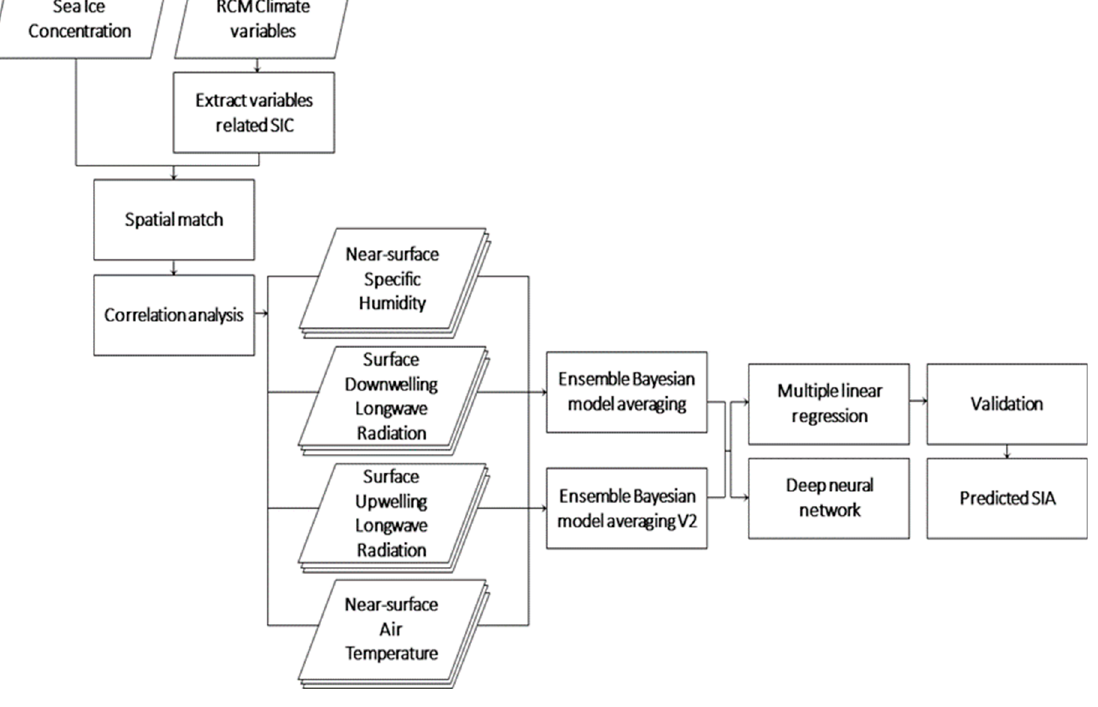
Figure 2. Overall flow diagram of this study.